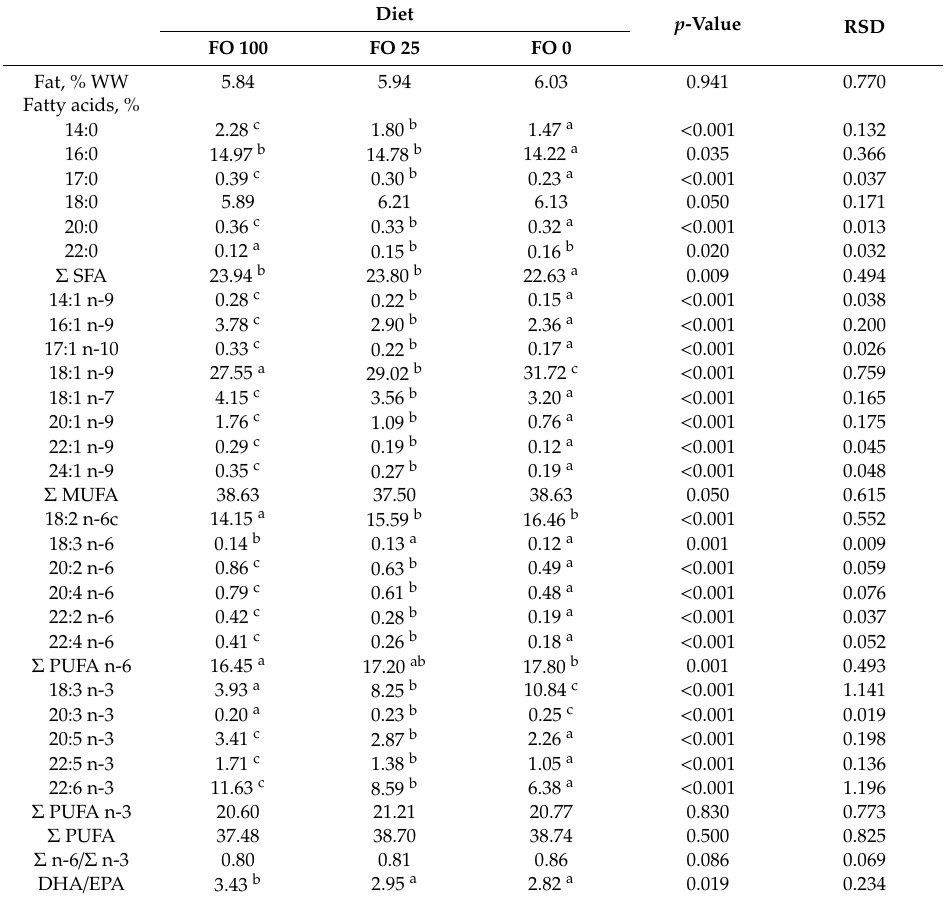
Table 7. Fat content and fatty acid composition (% of total fatty acid content) of the white muscle in Mediterranean yellowtails fed the experimental diets ( n = 12 per diet). Values are expressed as LS